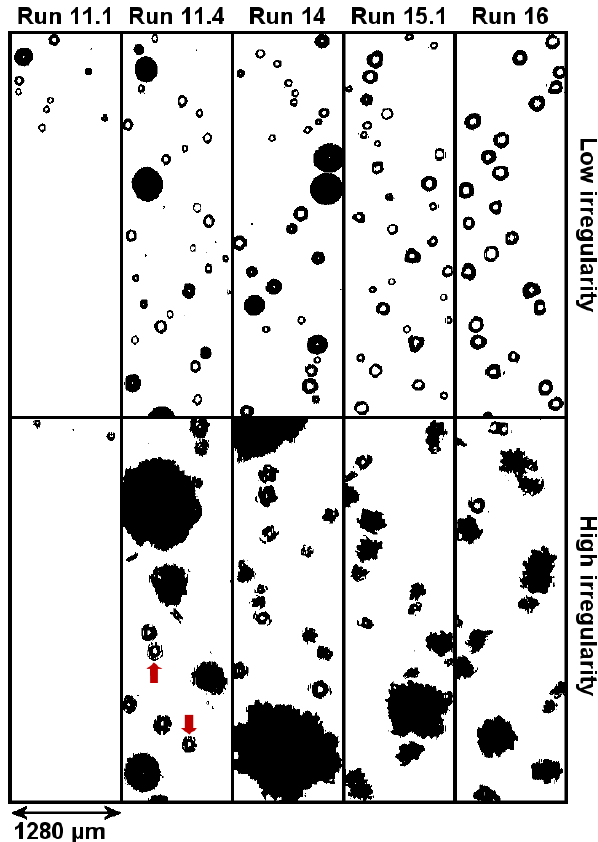
Figure 8. Images of hydrometeors measured by the 2DS during up- drafts in selected runs from Fig. 7. Images with holes in the centre are out of focus. The images highlighted by red arrows are exam- ples of frozen drops that may have also grown by vapour diffusion, as discussed in the text.